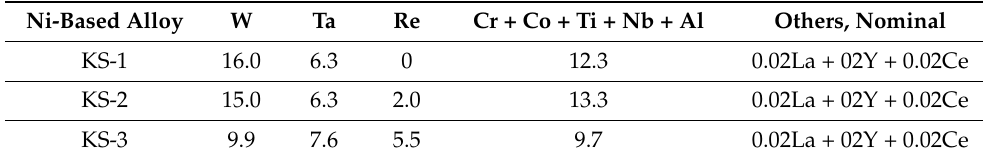
Table 1. Chemical compositions of single-crystal superalloys KS-(1-3) (wt. %). Ni-Based Alloy W Ta Re Cr + Co + Ti + Nb + Al Others, Nominal KS-1 16.0